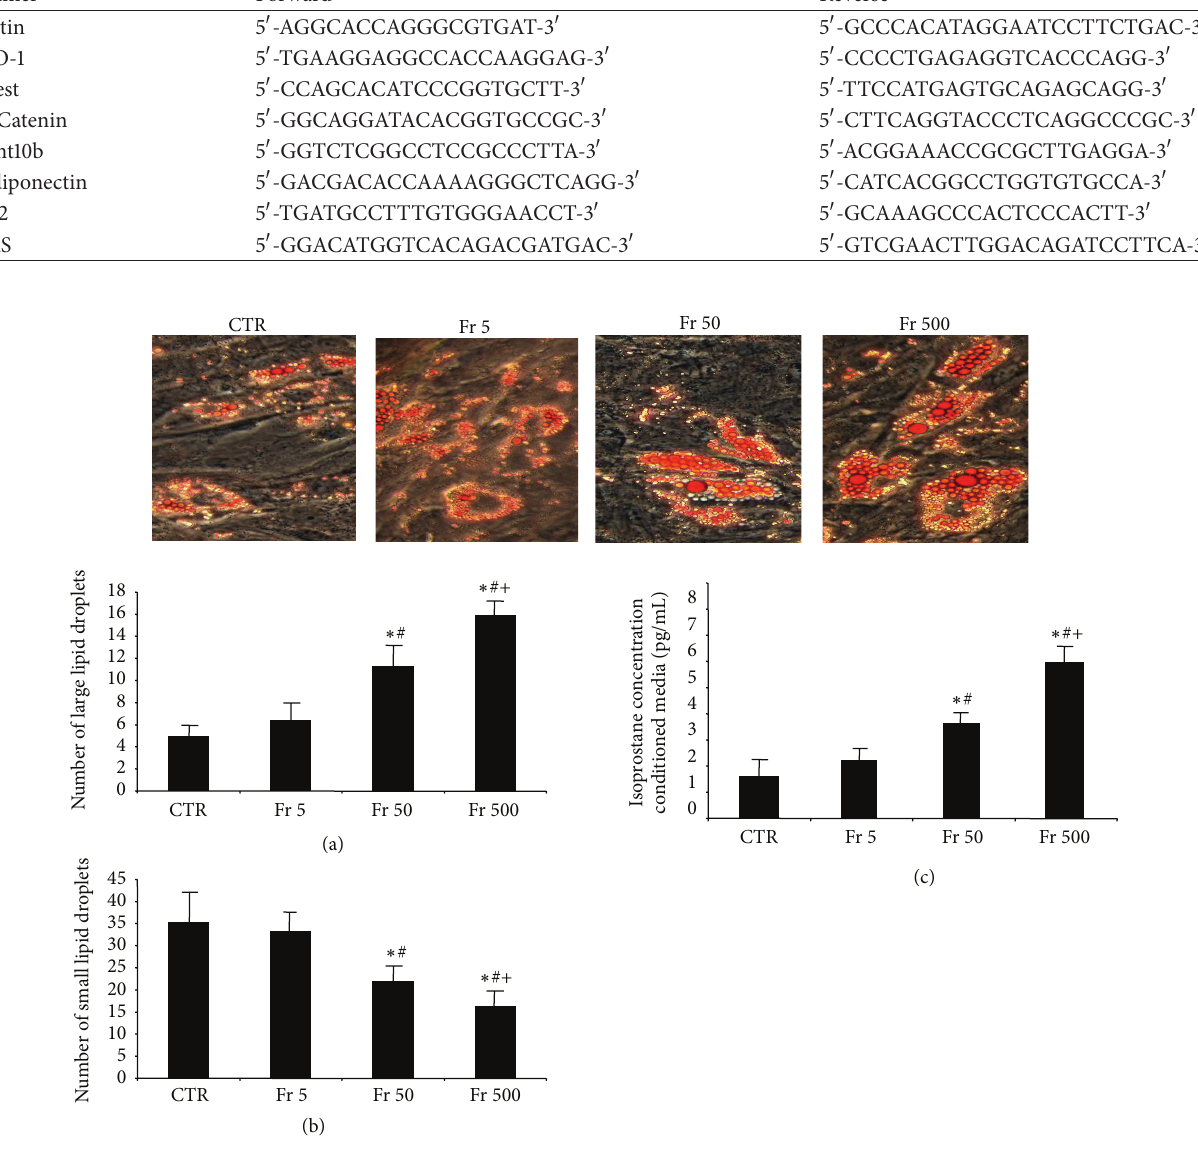
Figure 1: (a) Number of large lipid droplets from Oil Red O stained MSCs with 0, 5, 50, or 500 𝜇 M of fructose, magnifications: 40x ( 𝑛 = 3 ), and (b) number of small lipid droplets from Oil Red O stained MSCs with 0, 5, 50, or 500 𝜇 M of fructose, magnifications: 40x ( 𝑛 = 3 ). A representative section for each group is shown. (c) Measurement of isoprostane levels in conditioned media of differentiating MSCs. Values represent means ± SEM of five independent treatments. ∗ 𝑃 < 0.05 versus control or # 𝑃 < 0.05 versus Fr 5 𝜇 M or + 𝑃 < 0.05 versus Fr 50 𝜇